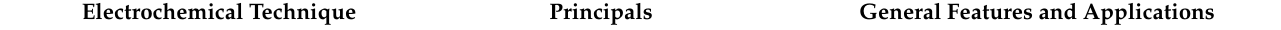
Table 3. Principles, features and applications of electrochemical techniques used in MIP-based electrochemical sensors. Electrochemical